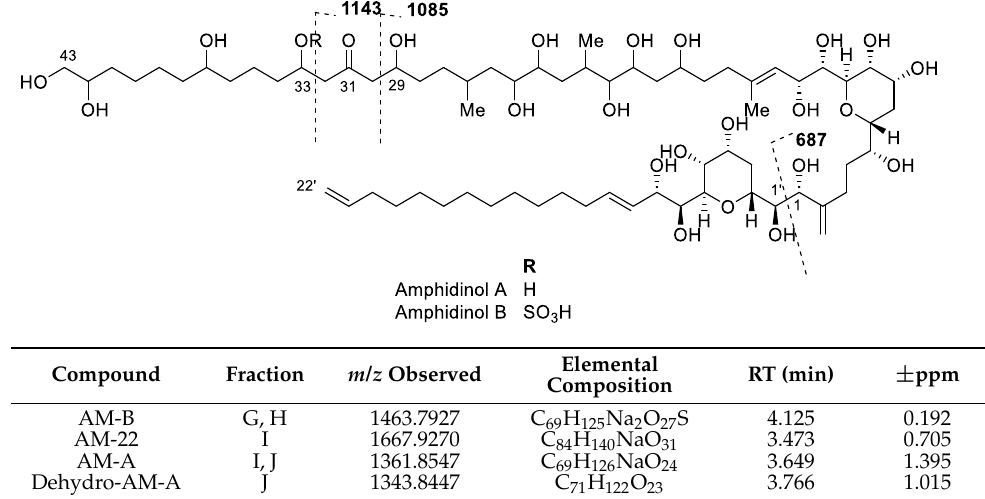
Table 1. Amphidinol derivatives present in fractions G–J.